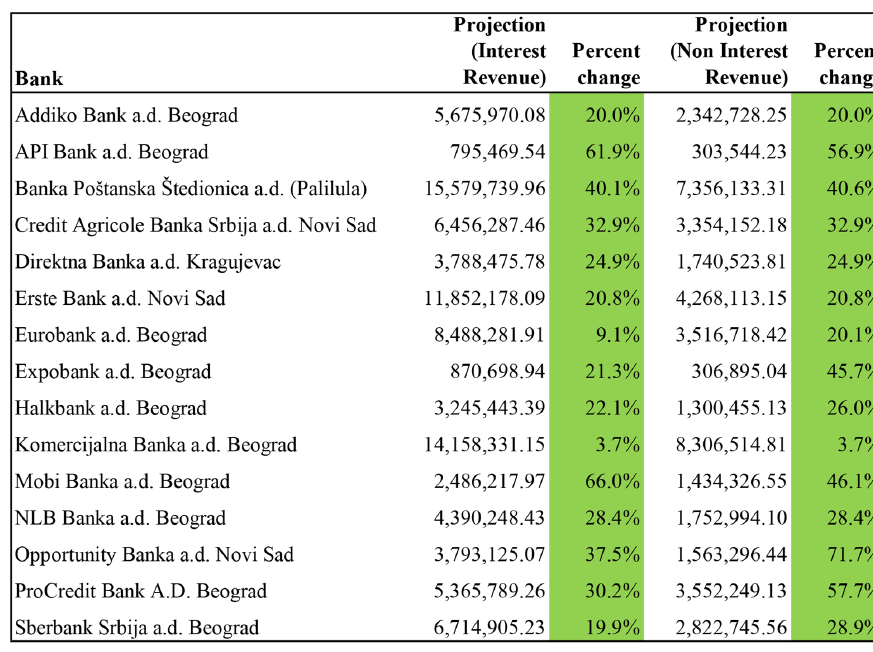
Figure 5. Targets for improvement for the inefficient Serbian commercial banks (in 000 SRB Dinars).